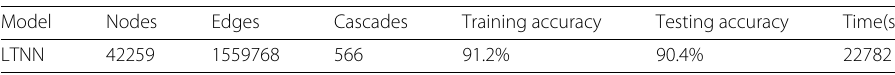
Table 4 Performance of large-scale real data Model Nodes Edges Cascades Training accuracy Testing accuracy LTNN 42259